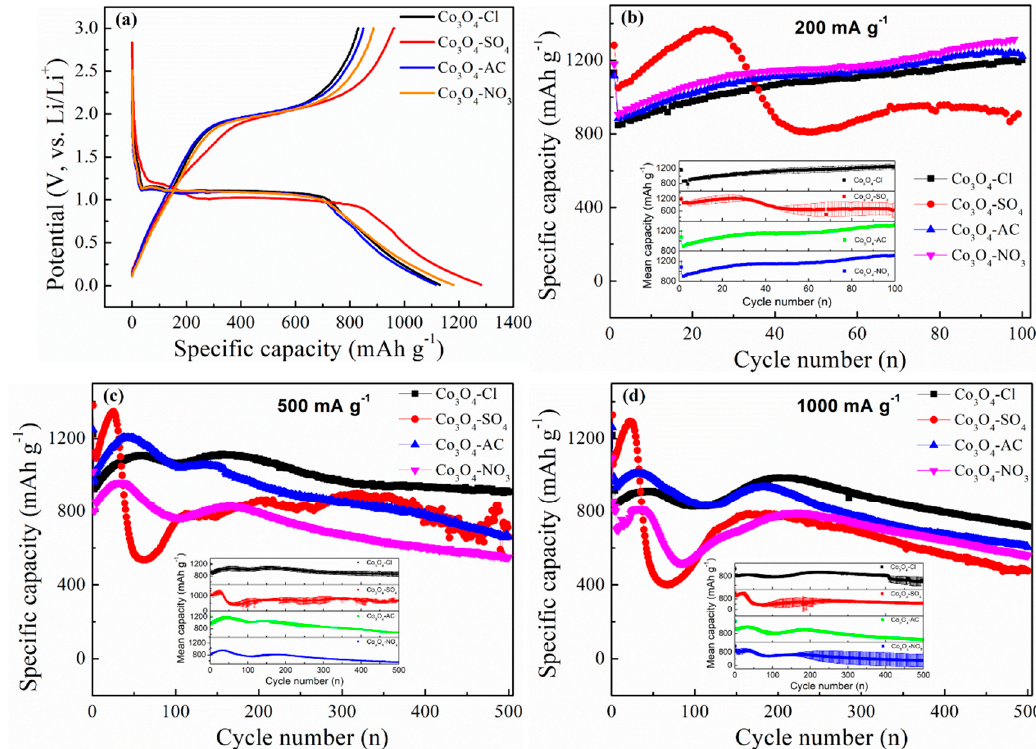
Figure 7. ( a ) Initial discharge–charge curves of Co 3 O 4 at 200 mA·g − 1 . Cycle performance of different Co 3 O 4 at the current density of ( b ) 200 mA·g − 1 , ( c ) 500 mA·g − 1 , and ( d ) 1000 mA·g − 1 . The insert pictures represent the error bar with standard deviation. The specific capacity corresponds to the discharge process, i.e., Co 3 O 4 reacts with Li + to form Co and Li 2 O.